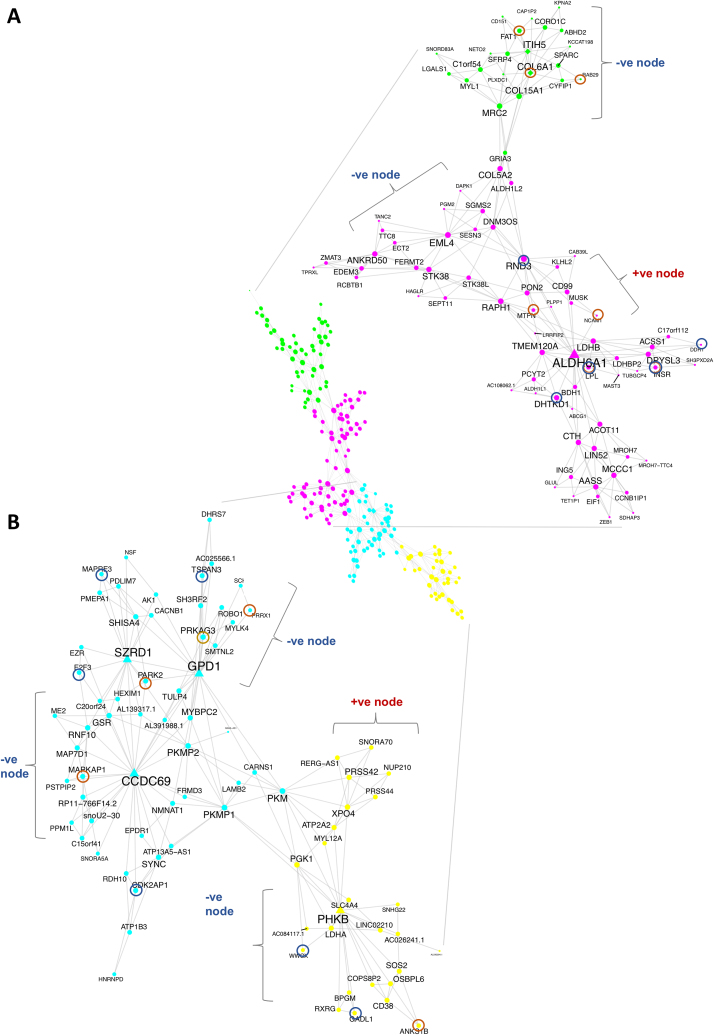
Treatment-responsive IS networks regulate human peripheral insulin sensitivity and link to metabolic disease risk genes. Probabilistic networks have been utilized to establish a causal relationship between molecules and disease (5). We utilized the dynamic response to diverse forms of treatment aimed at reversing insulin resistance, along with measured fasting relationships to estimate if planar filtered networks (77) derived from 191 of the younger individuals (<70yr), were enriched in genes dynamically regulated or were lncRNAs, harboring causal genetic variant related to metabolic disease, or dominated by proven T2DM disease pathways. MEGENA (77) was used to identify discrete planar filtered networks using the CORE-IS gene list as input (FDR <1% and spearman rank correlation; P<0.01 for module significance and P< 0.01 for network connectivity). Follow-up protein–protein interaction analysis (79) facilitated the interpretation of the identified networks providing additional biological plausibility to each network (78). Node and label size are proportional to the node degree value within each distinct module. (A) represents the largest discrete planar filtered network (87 genes, 13% ncRNA and 64% negatively co-varying with in vivo fasting IS) that protein–protein interaction analysis identified as being involved with hormone signaling, including insulin, FDR<1%. This network contained 44% (7; ALDH6A, DHTKD1, KPNA2, MCCC1, PCYT2, PGM2 and RND3) of the 16 genes regulated in vivo proportional to changes in IS, across four independent treatment studies. Further, 33% of the life-style treatment-response genes (ALDH6A DHTKD1, PCYT2 and RND3) were responsive to three months of PPARγ agonist, given to insulin resistant subjects ((Supplemental data S5, (56)). There were numerous significant GWAS loci for T2DM (gene ID enclosed in blue-ring) or Obesity (gene ID enclosed in brown circle). (B) The second largest and discrete planar filtered network (81 genes, 22% ncRNA and 75% negatively co-varying with in vivo fasting IS) contained genes from GWAS loci for T2DM, Obesity and Lipids (gene ID enclosed in gold circle). Twenty-five percent of this network was responsive to anti-diabetes drug treatment (PPARγ agonist), given to insulin resistant subjects for three months (56). Protein–protein interaction analysis indicated that this module was enriched by genes (33 in the network, FDR < 1 × 10−5) involved in the positive regulation of RNA metabolism and transcription.